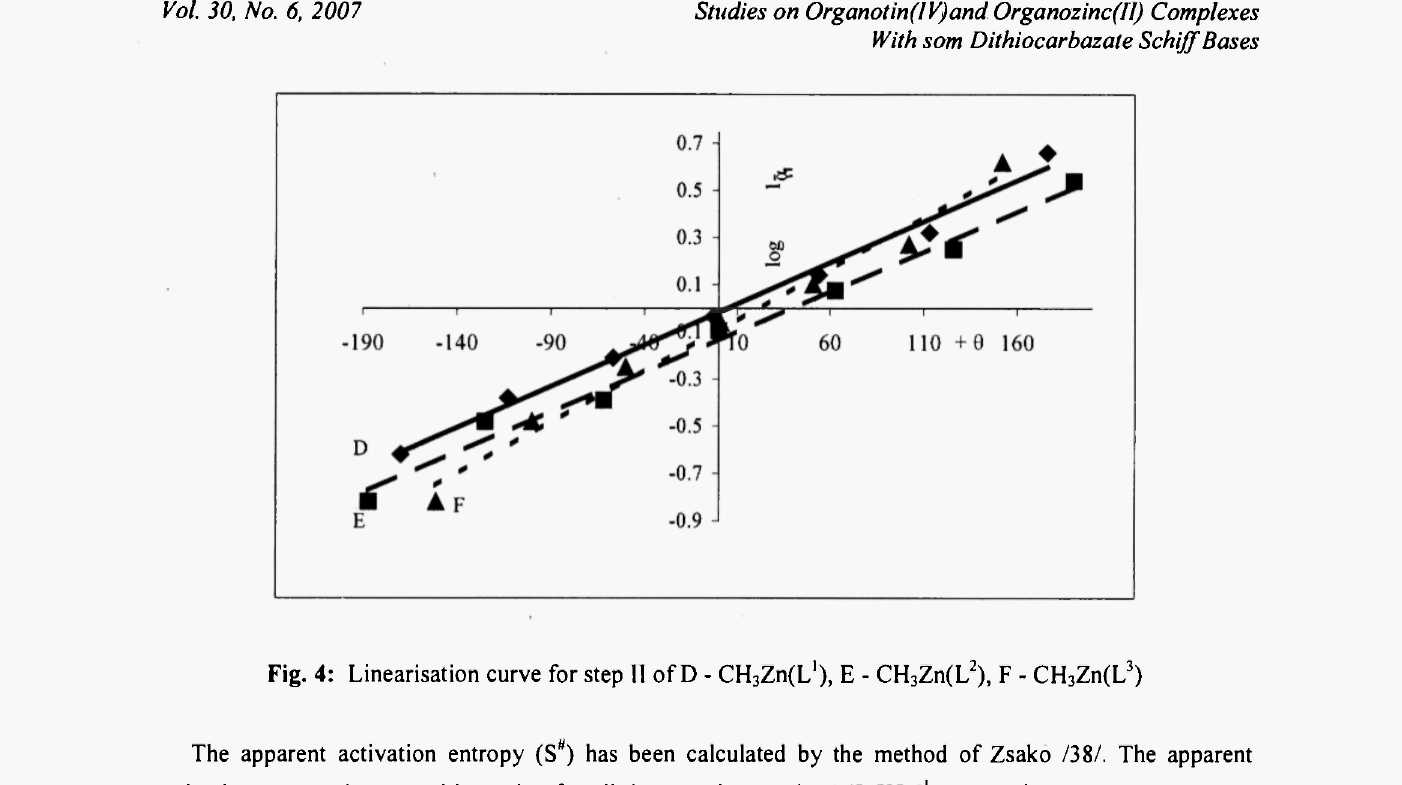
The apparent activation entropy (S") has been calculated by the method of Zsako /38/. The apparent activation entropy has a positive value for all the complexes. The AH (KJg" 1 ) values for the first and second decomposition steps of the complexes have been taken from DTA curves. The comparative thermodynamic and kinetic parameters are listed in table